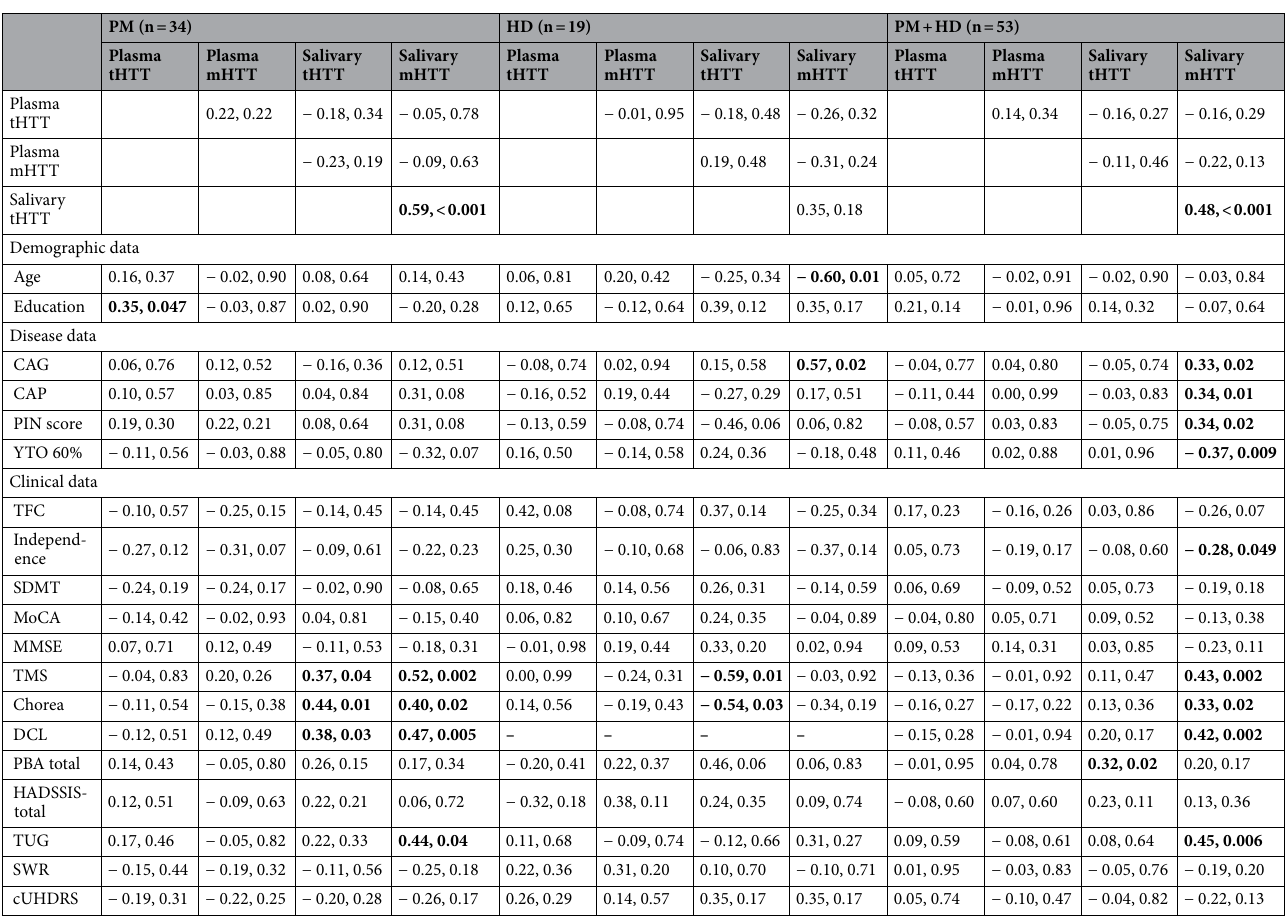
Table 3. Relationship between plasma and salivary tHTT, mHTT, with demographic and clinical factors (r, p). CAP, CAG-Age Product; YTO 60%, years to predicted manifest onset at 60% probability; TFC, Total Functional Capacity; SDMT, Symbol Digit Modalities Test; MoCA, Montreal Cognitive Assessment; MMSE, Mini-Mental State Examination; TMS, Total Motor Score; DCL, Diagnostic Confidence Interval; PBA Total, PBA, Problem Behaviors Assessment Total, HADS-SIS, Hospital Anxiety and Depression Scale-Snaith’s Irritability Scale; TUG, Timed Up and Go; cUHDRS, composite Huntington’s Disease Rating Scale. Bold cells were significant ( p < 0.05) before adjusting for